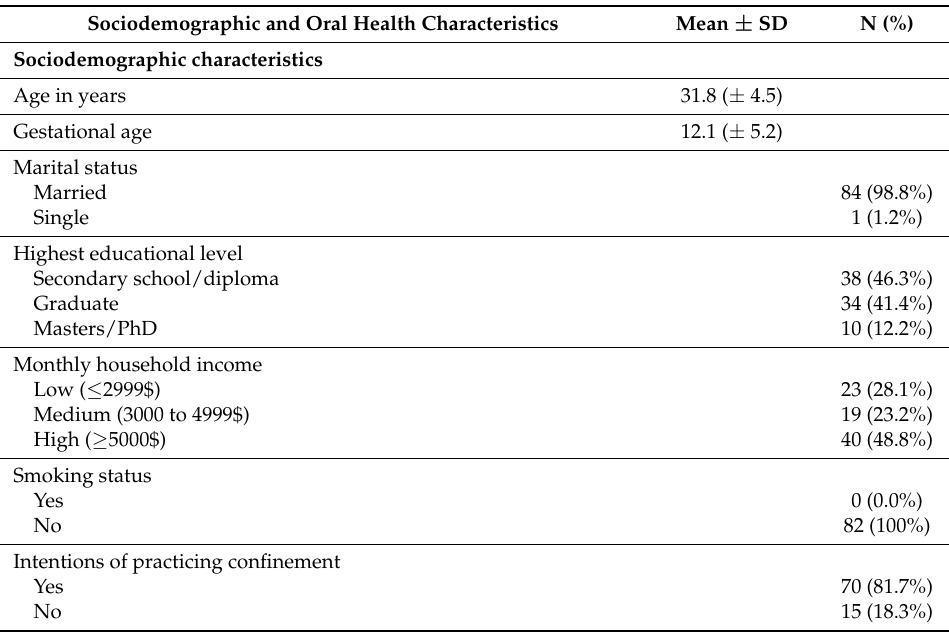
Table 1. Sociodemographic and oral health characteristics (N =